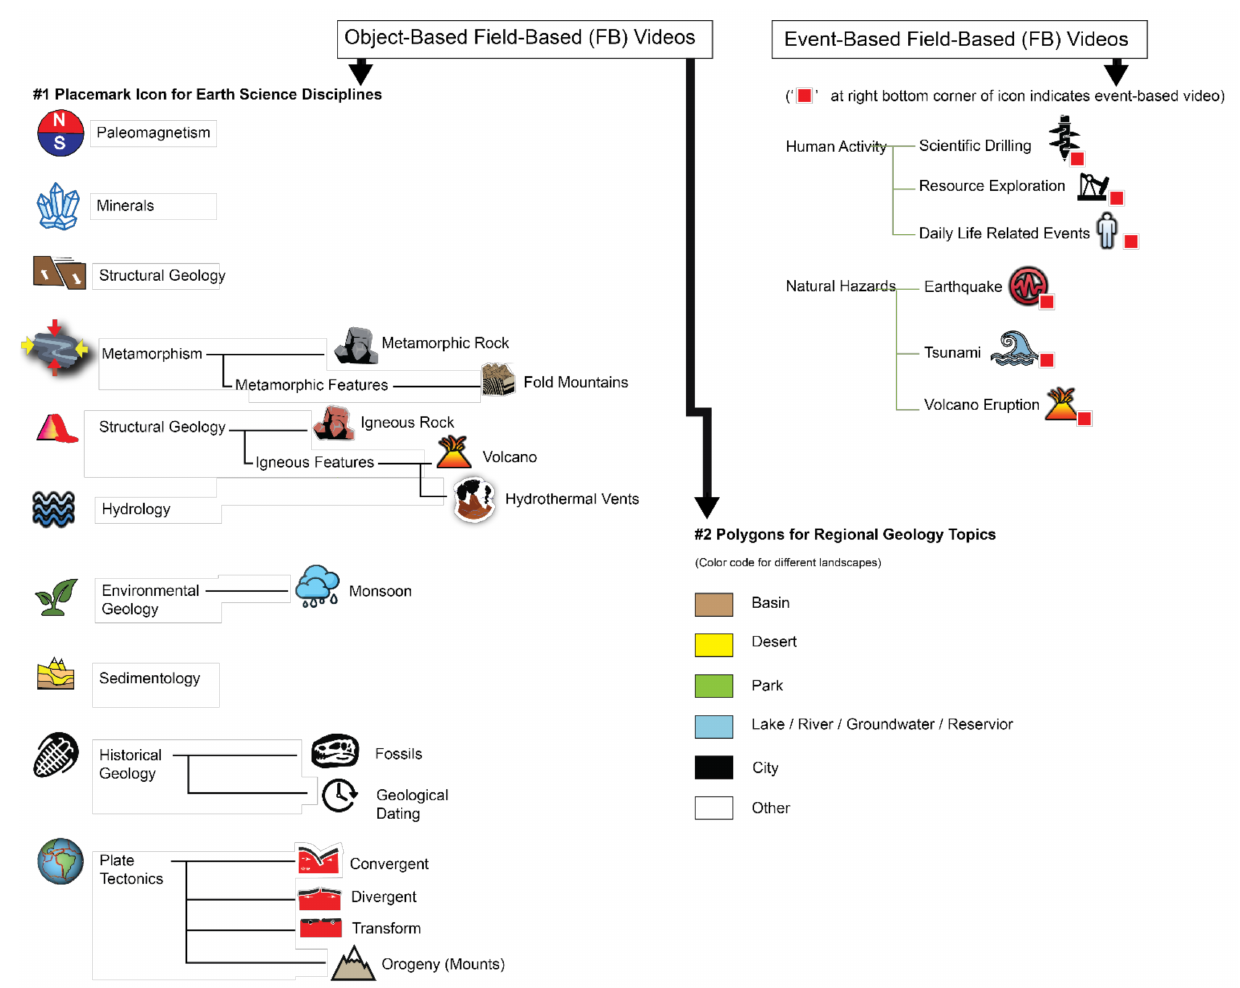
Figure 2. GEGVL placemark representations for two types of FB videos: object-based videos and event-based videos. Regional geology videos are represented with polygons because they cannot be categorized into any single geological discipline or represented with a single